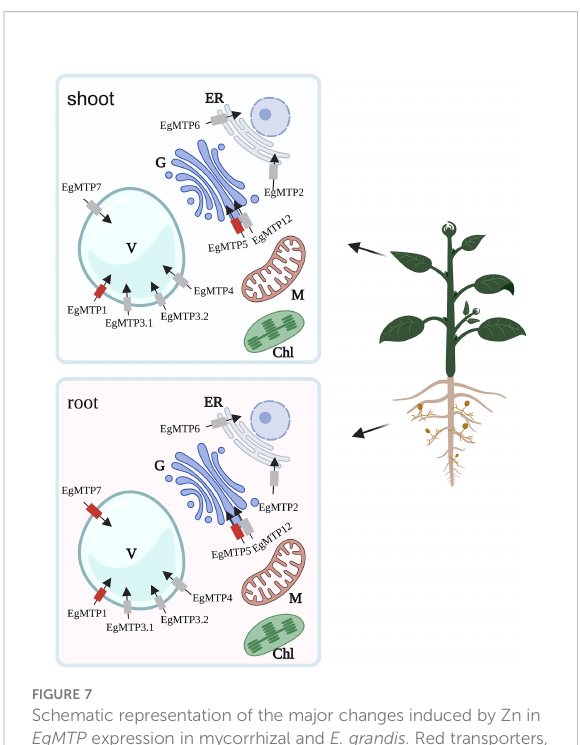
FIGURE 7 Schematic representation of the major changes induced by Zn in EgMTP expression in mycorrhizal and E. grandis . Red transporters, upregulated EgMTPs by mycorrhizal; ER, endoplasmic reticulum; V, vacuole; G, golgi; Chl, chloroplast; M,